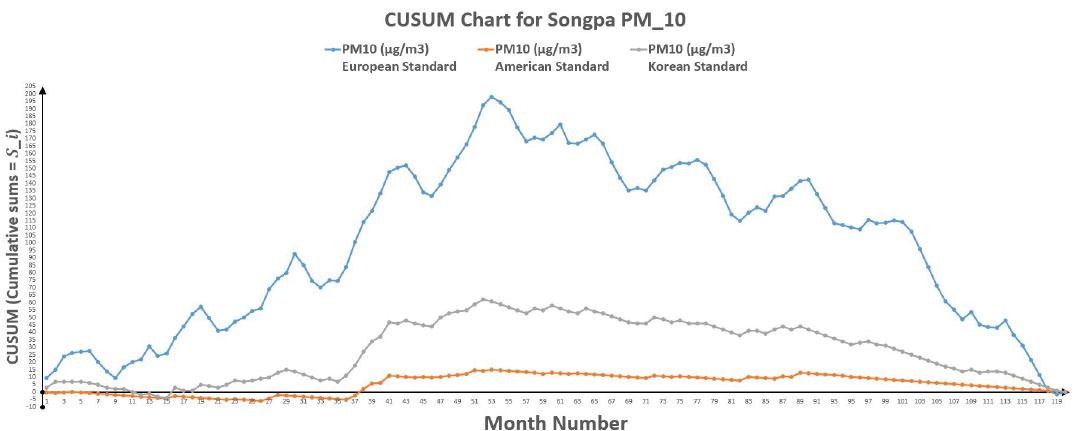
Figure 7. CUSUM chart for Songpa PM 10 .